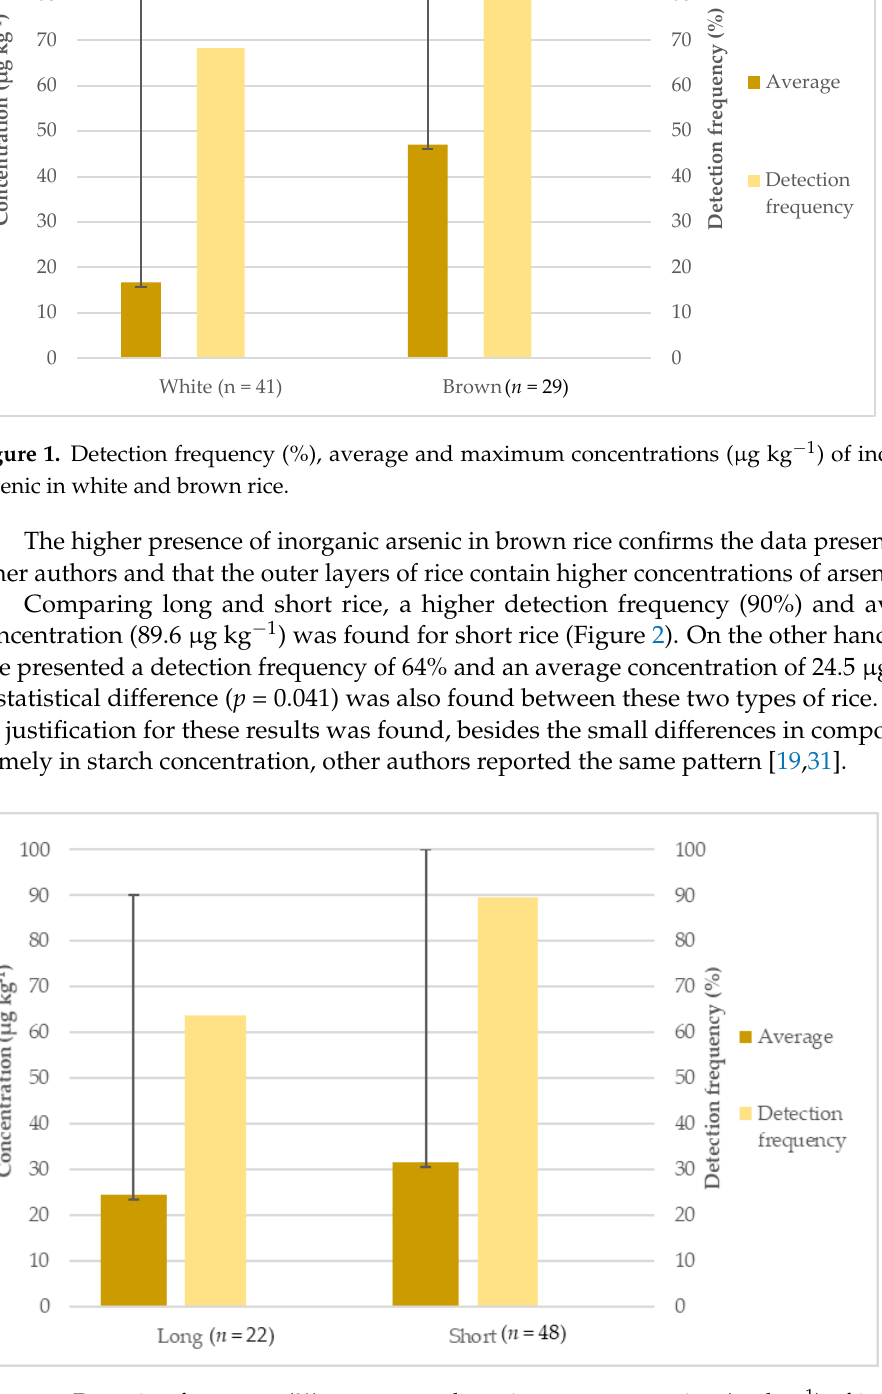
Figure 2. Detection frequency (%), average and maximum concentration (µg kg −1 ) of inorganic arsenic in long and short rice.